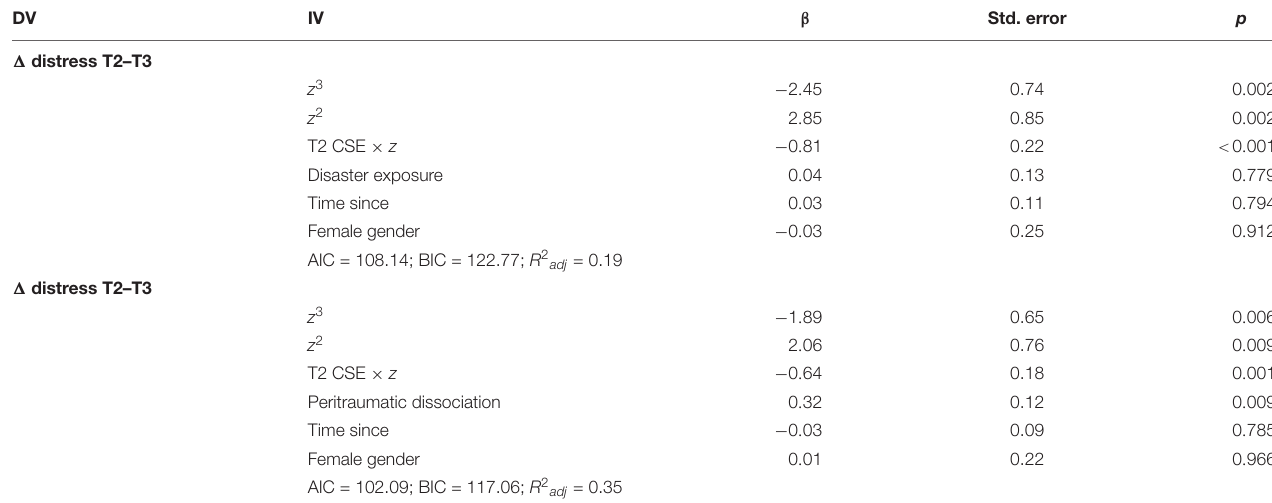
TABLE 8 | Standardized coefficients, standard error, and p -values for the cusp model in distress between time 2 and time 3 without participants suffering from the camp fire. DV IV β Std. error